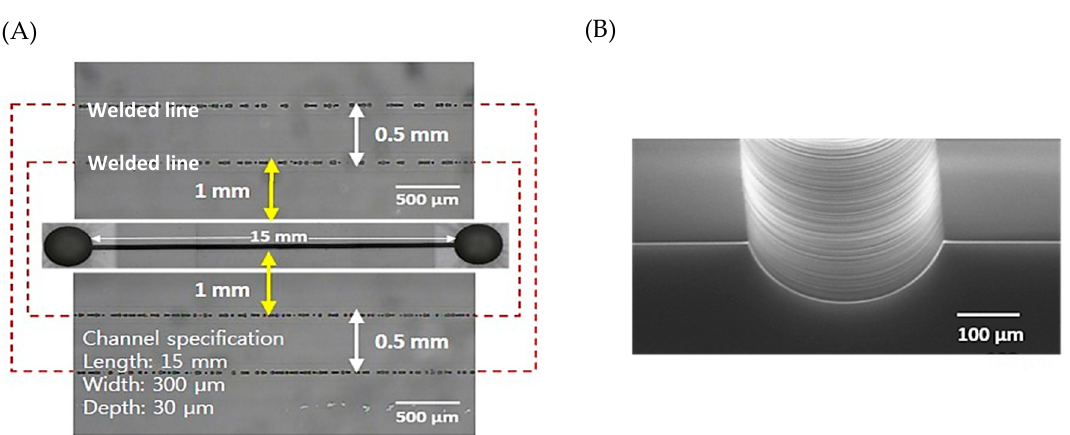
Figure 5. ( A ) Top view of glass microfluidic device using laser assisted selective etching (LASE) and welding. Channel specifications: length 15 mm, width 300 μ m, and depth 30 μ m. Red dash line welding area. ( B ) Scanning electron microscope (SEM) image showing the formed microfluidic channel with a surface roughness of 360 nm (Ra).